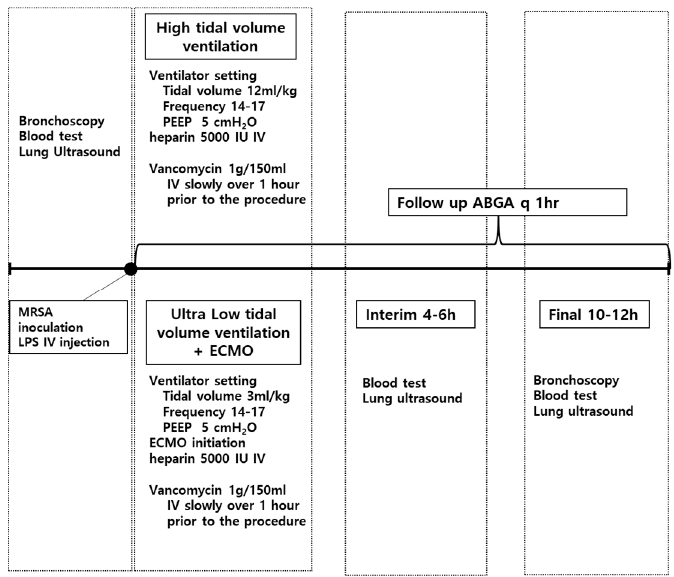
Figure 1. Schematic representation of the experiment protocol. MRSA: Methicillin-resistant Staphylococcus aureus , LPS: Lipopolysaccharide, IV: Intravenous, PEEP: Positive end-expiratory pressure, ECMO: Extracorporeal membrane oxygenation, ABGA: Arterial blood gas analysis, h: